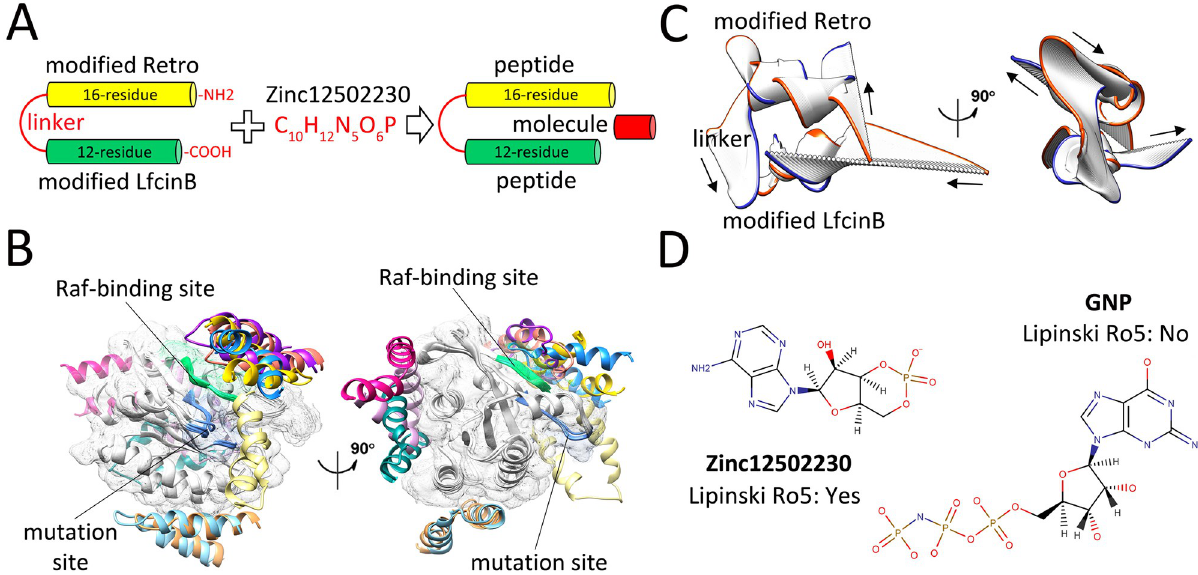
Fig 5. Binding energy and structural evaluations of final selected peptides and molecule. ( A ) Schematic representation of dimer peptide construction and combination of this peptide with Zinc12502230. ( B ) Ten top-ranked peptide-protein complexes obtained from flexible docking of the modified Retro-LfcinB peptide (each pose in a different color) with K-Ras G12D (gray). The Raf-binding and mutation sites are shown in green and blue colors, respectively. ( C ) The dominant mode of motion resulted from 50 frames of Retro-LfcinB MD simulations. The orange and blue colors represent the first and last frames, respectively. Arrows show the direction of motions. ( D ) Molecular representation of the small molecule Zinc12502230 (left) and GNP (right).